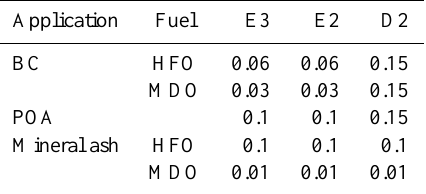
Table 2. Emission factors for BC, POA and mineral ash in g ( kWh ) − 1